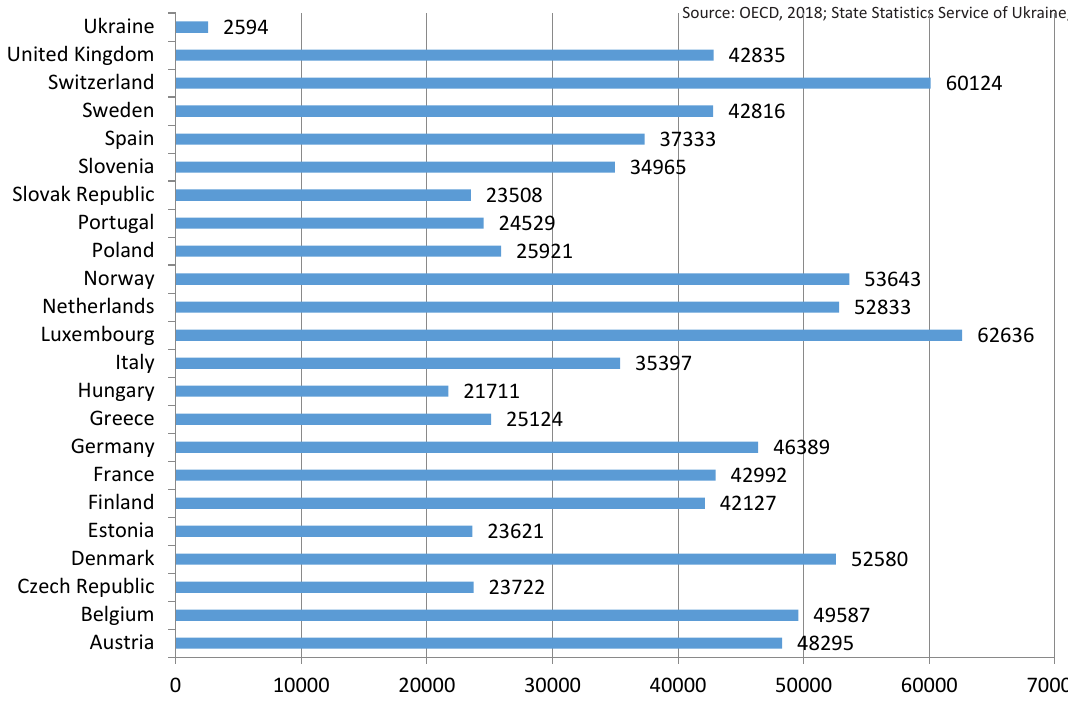
Figure 1. Average annual wages in European countries of OECD and Ukraine in 2016,